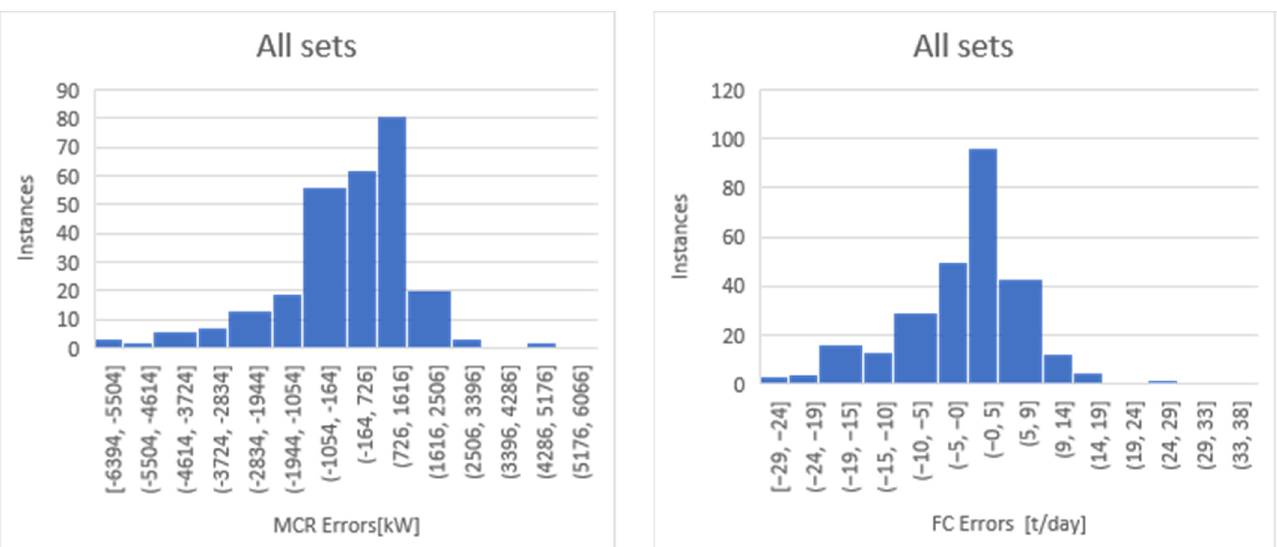
(FC) of bulk carriers.